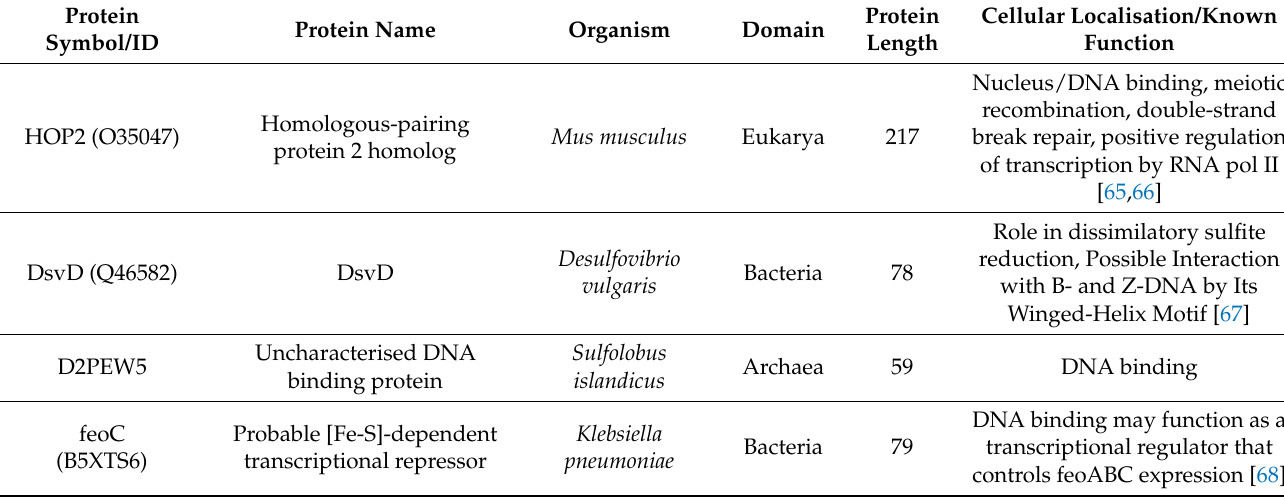
Table 2. Predicted Z-DNA/RNA binding proteins based on structural similarity to the